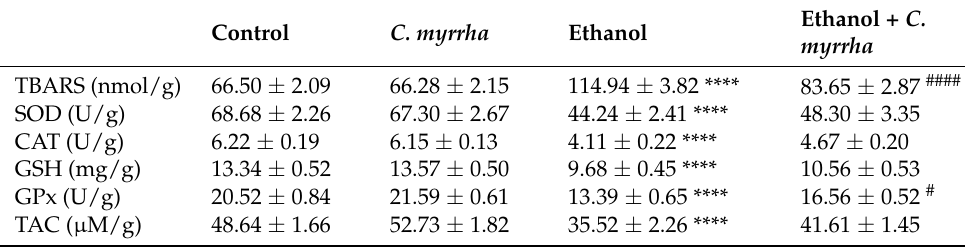
Table 2. Effects of C. myrrha extract (500 mg/kg) and/or ethanol (40%, 3 g/kg) on lipid peroxidation biomarker and antioxidant activity in hepatic tissue after 30 days of treatment. TBARS, thiobarbituric acid-reactive substances; SOD, superoxide dismutase; CAT, catalase; GSH, reduced glutathione; GPx, glutathione peroxidase; TAC, total antioxidant capacity. Ethanol + C. Control C. myrrha Ethanol myrrha TBARS (nmol/g) 66.50 ± 2.09 66.28 ± 2.15 114.94 ± 3.82 **** 83.65 ± 2.87 #### SOD (U/g) 68.68 ± 2.26 67.30 ± 2.67 44.24 ± 2.41 **** 48.30 ± 3.35 CAT (U/g) 6.22 ± 0.19 6.15 ± 0.13 4.11 ± 0.22 **** 4.67 ± 0.20 GSH (mg/g) 13.34 ± 0.52 13.57 ± 0.50 10.56 ± 0.53 GPx (U/g) 20.52 ± 0.84 21.59 ± 0.61 16.56 ± 0.52 # TAC ( µ M/g) 48.64 ± 1.66 52.73 ± 1.82 35.52 ± 2.26 **** 41.61 ±